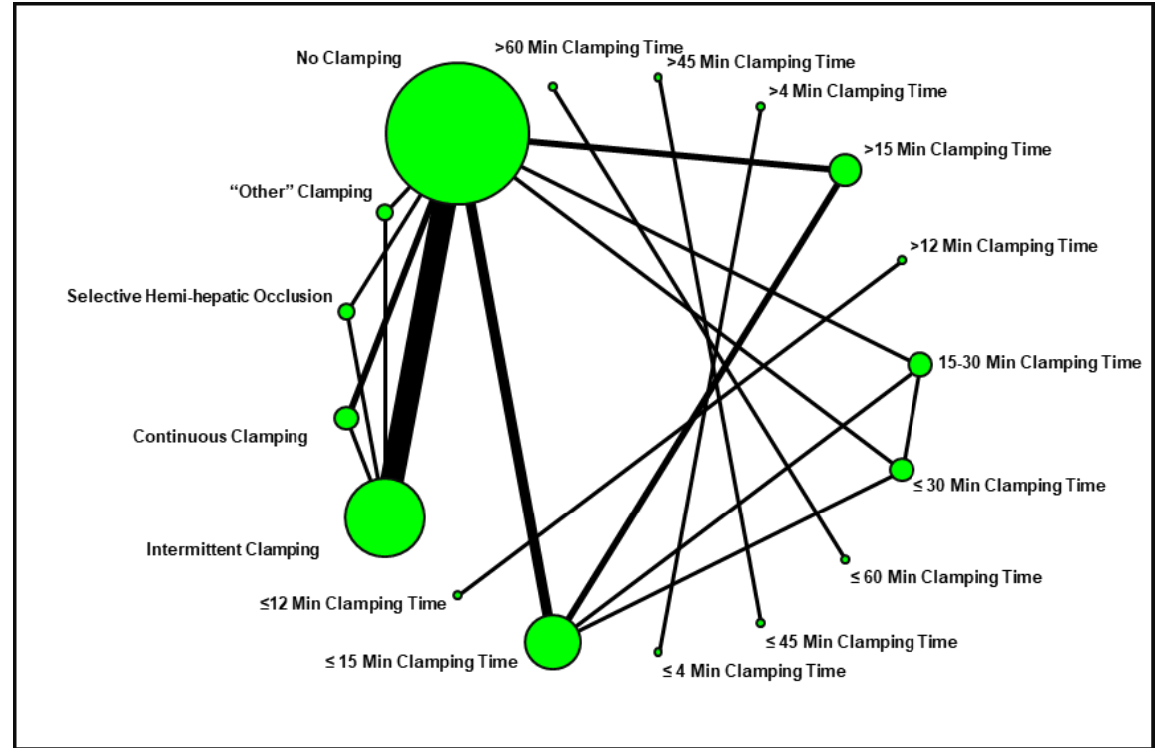
Figure 2. Network plot summarizing the comparisons assessed in the current systematic review.